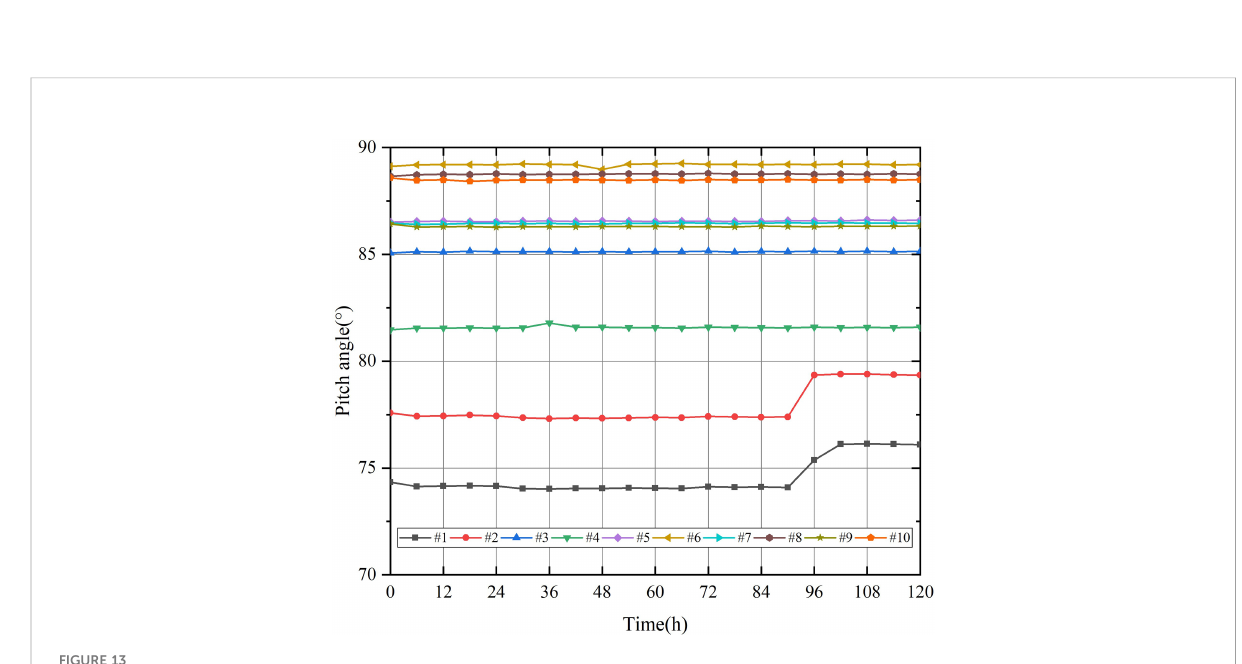
FIGURE 13 Pitch angle of the sensor